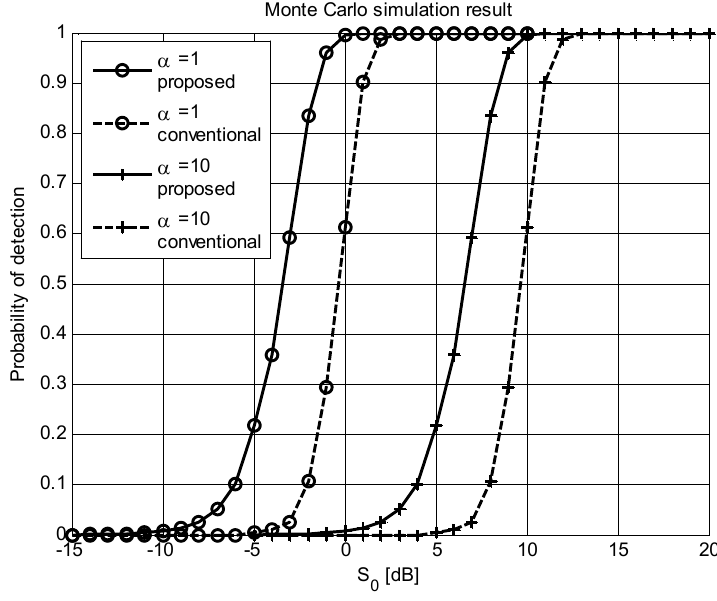
Figure 8. The probability of detection by computer simulation for the proposed and conventional methods with the same threshold for α = 1 and 10 with λ =